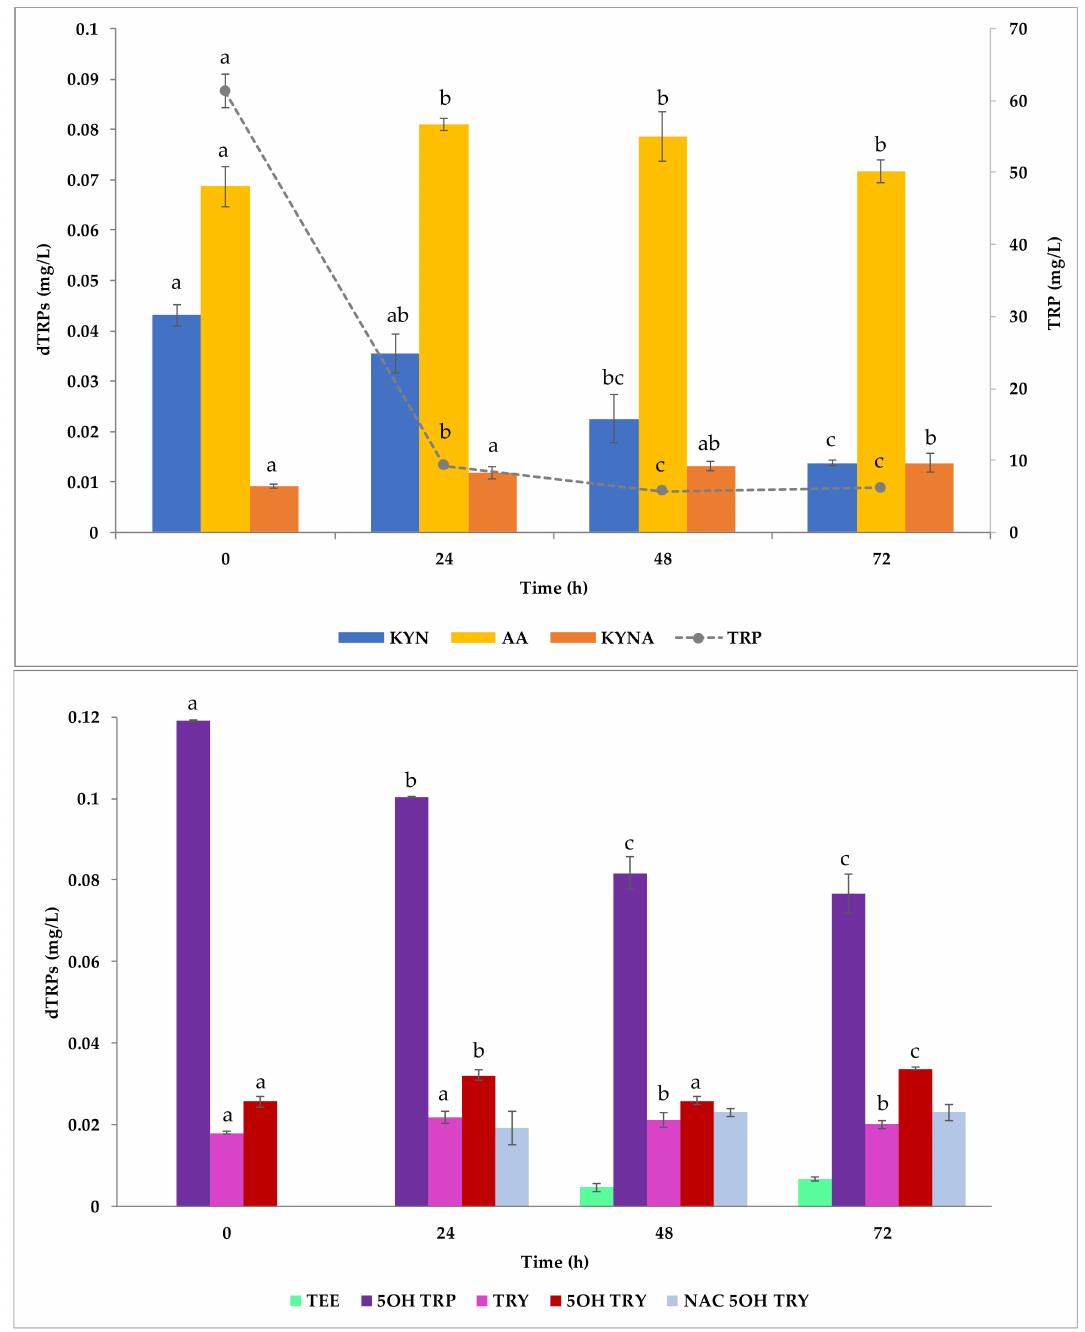
Figure 7. TRP derivatives produced by S. cerevisiae EC1118 in fermentation experiments in YNBSOY medium. Error bars indicate the standard deviation among the means of biological replicates. Letters indicate the grouping information using the Fisher LSD Method and 95%